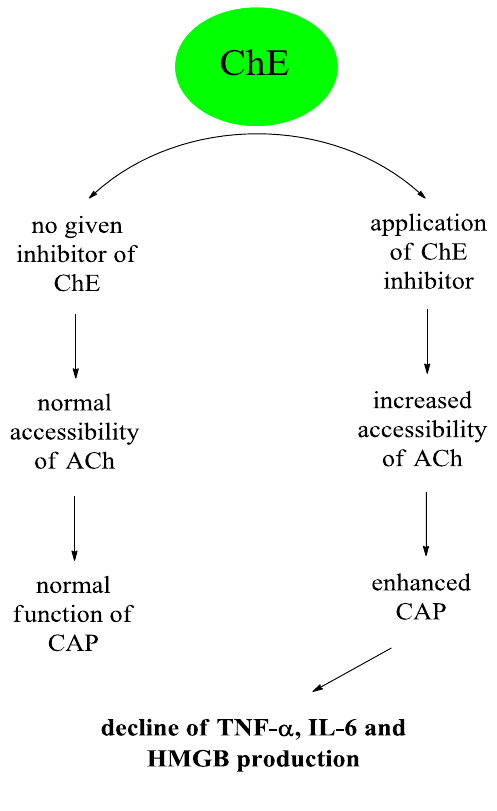
Figure 5. Simplified scheme for showing how inhibitors of cholinesterases may be involved in regulation of immunity using the cholinergic anti-inflammatory